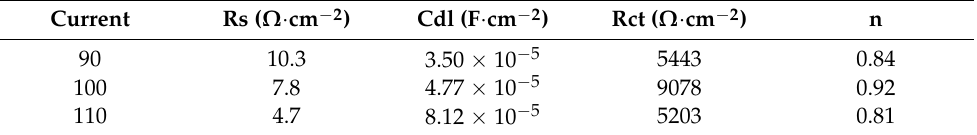
Table 3. Fitting parameters of EIS results obtained from a proposed equivalent model.